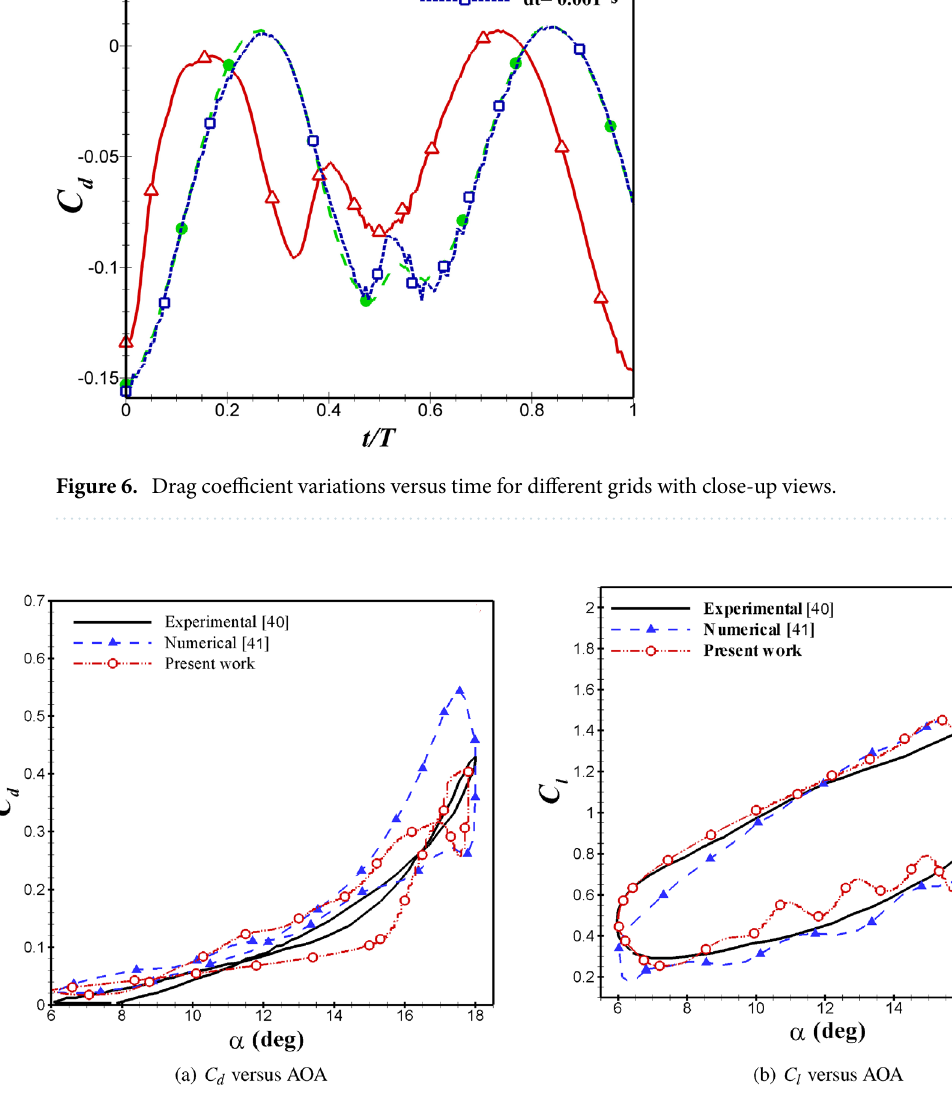
Figure 7. Comparison of aerodynamic coefficients with Refs. 40,41